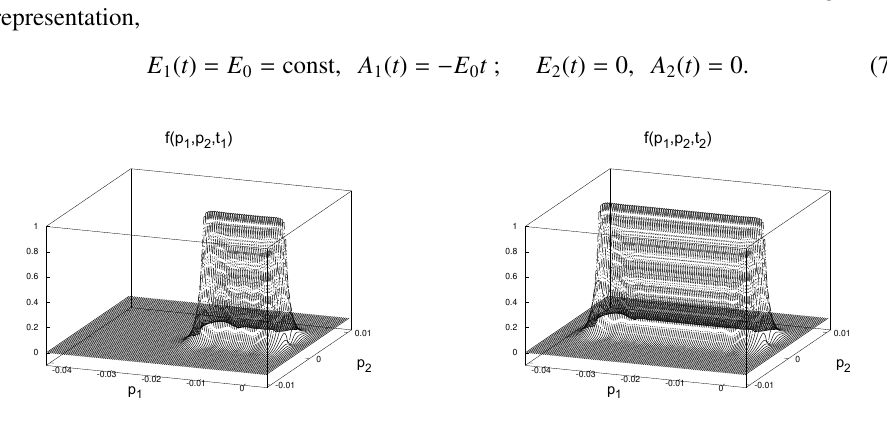
Figure 1. The distribution function in the 2D momentum space for two consecutive points of time at the field strength 0 . 1 V / µ m. Left panel: t 1 = 0 . 5 × 10 − 12 s, Right panel: t 2 = 1 . 0 × 10 − 12 s